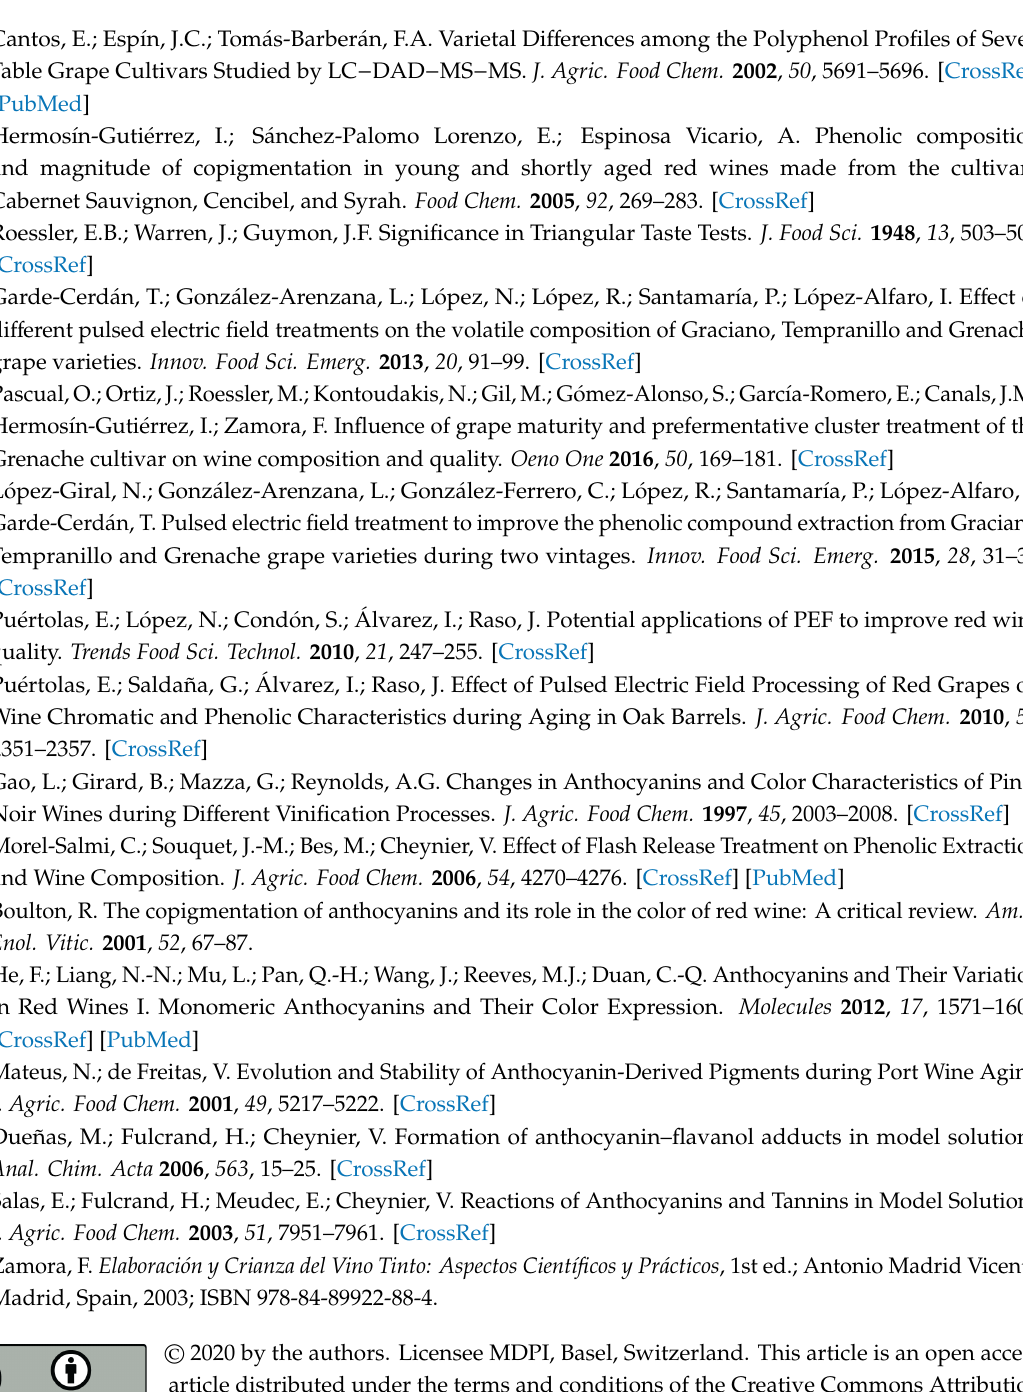
Table Grape Cultivars Studied by LC − DAD − MS − MS. J. Agric. Food Chem. 2002 , 50 , 5691–5696.